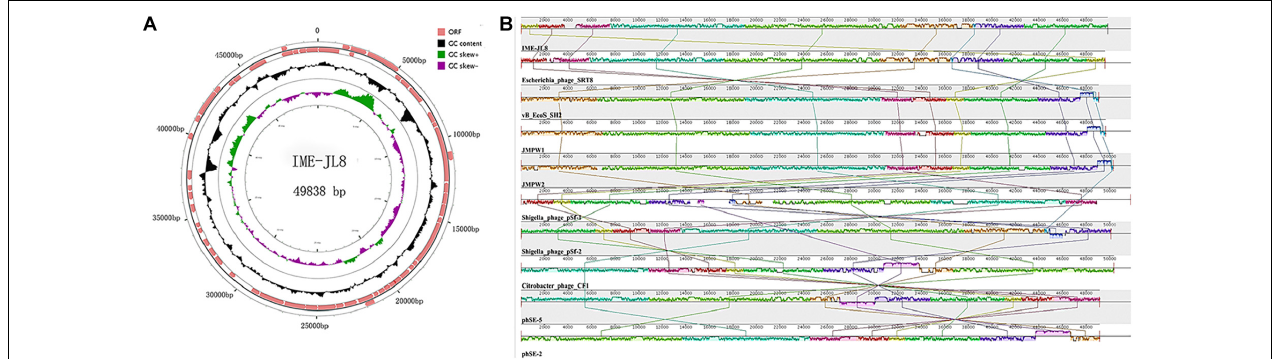
FIGURE 3 | Genome characteristics of IME-JL8. (A) The genetic and physical organization of the IME-JL8 genome. ORFs with 80 or more residues are represented by arrows and the arrowheads point in the transcription direction. The figure also maps the G+C content, which is skewed. (B) Multiple genome alignments among IME-JL8 and other homologous phages. Similarity is indicated by the height of the bars, complying with the average level of conservation in that region of the genome sequence. The homologous phages are marked in the picture.